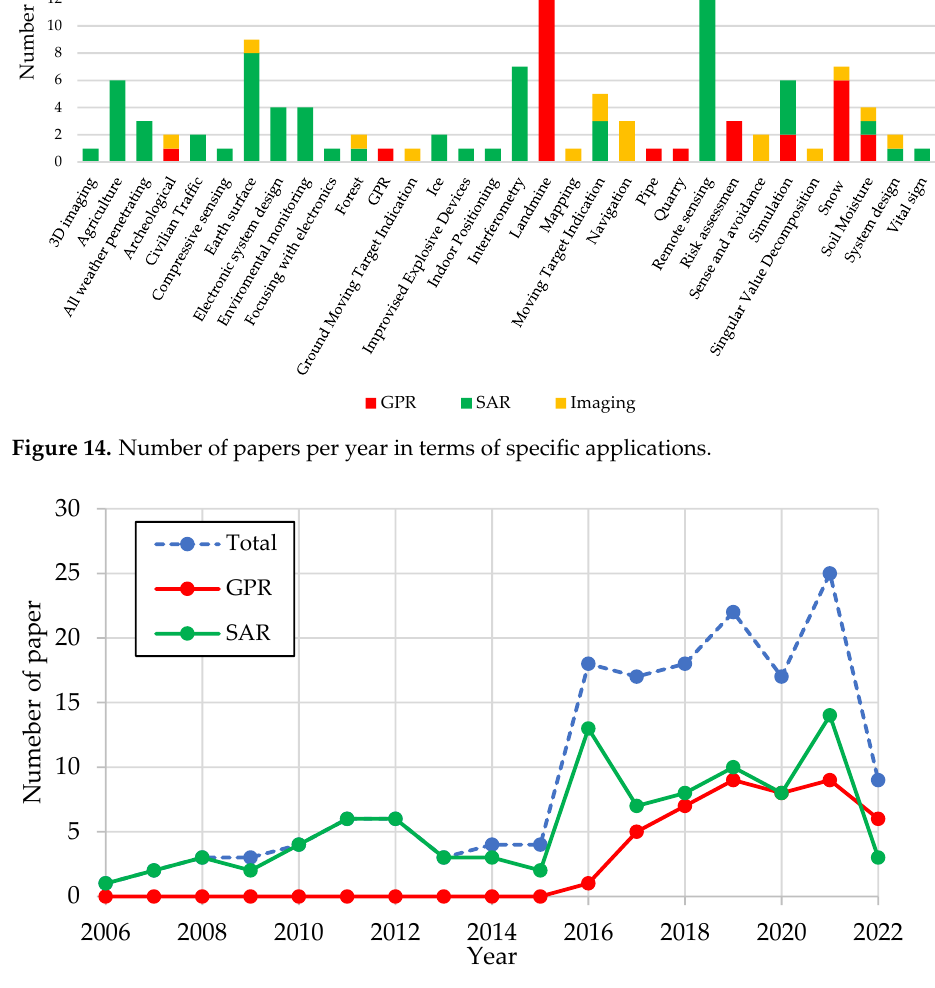
( e ) Figure 16. Examples of types of UAS: Fixed-wing ( a ) (after [60]) and ( b ) (after [61]); and multi-copter ( c ) (after [14]), ( d ) (after [45]), and ( e ) (after [62]). Figure 17 shows the percentage of papers per year related to a specific UAS category. The sum of the percentage of paper per type is not always 100% since in some papers, the authors have not declared the type of UAS used. We can notice an inversion between fixed-wing and multi-copter in 2016. Before 2016, nearly all of the publications used a